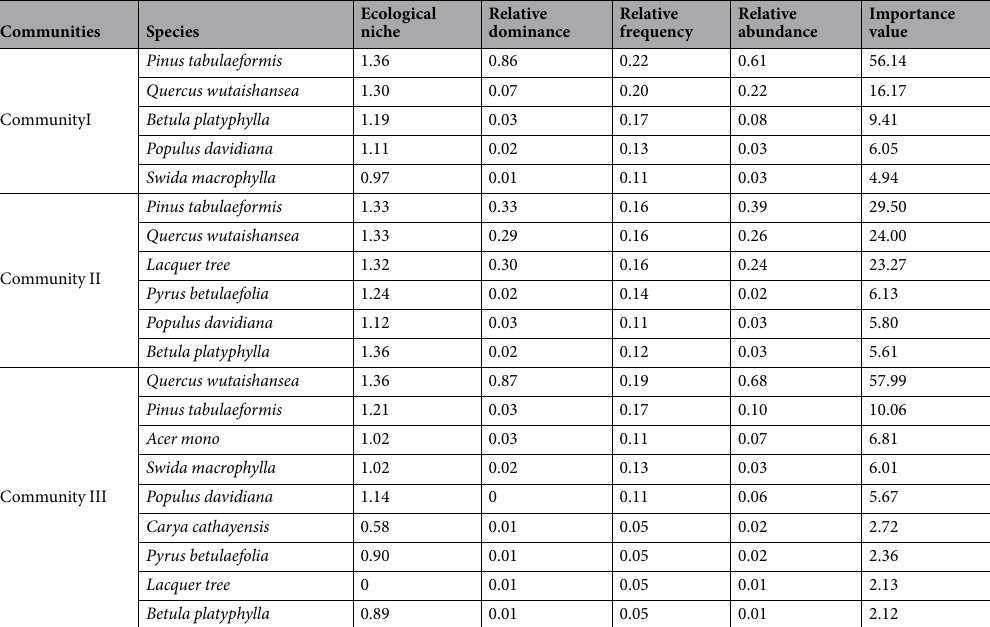
Table 2. Importance value and niche breadth of dominant species in different communities (Importance value >